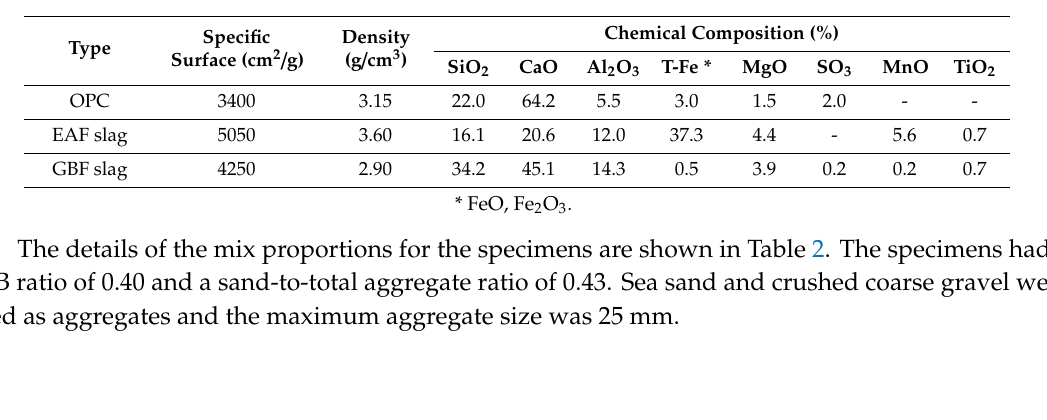
Table 1. Physical properties and chemical composition of the cement and slags.